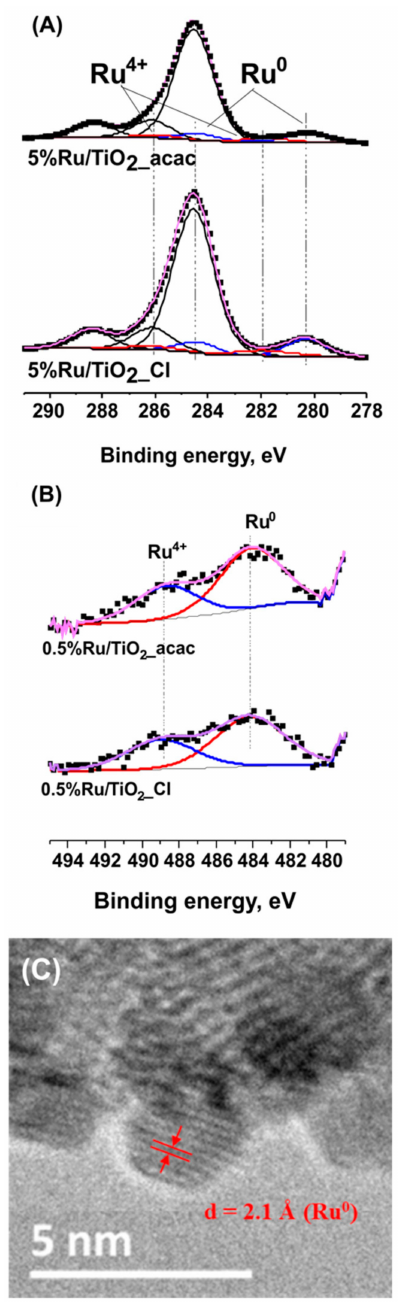
Figure 3. ( A ) Ru 3p and ( B ) Ru 3d + C 1s XPS profile of the Ru(0.5 wt.%)/TiO 2 -P25 catalyst